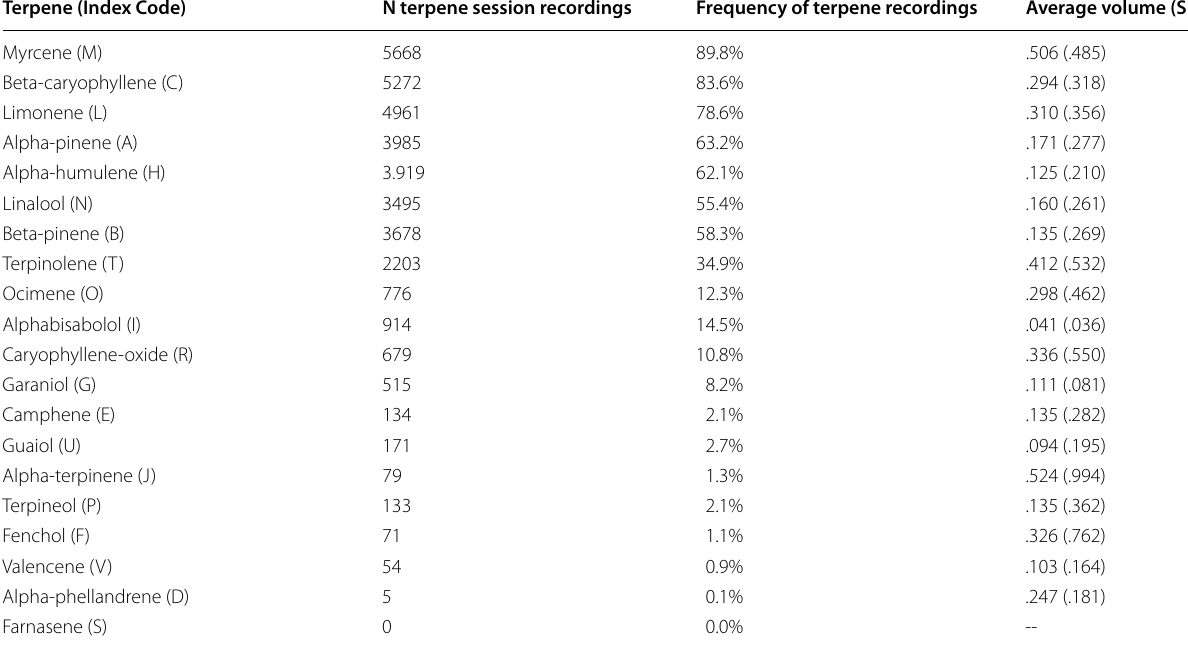
All terpenes available for selection in the ReleafApp ™ are